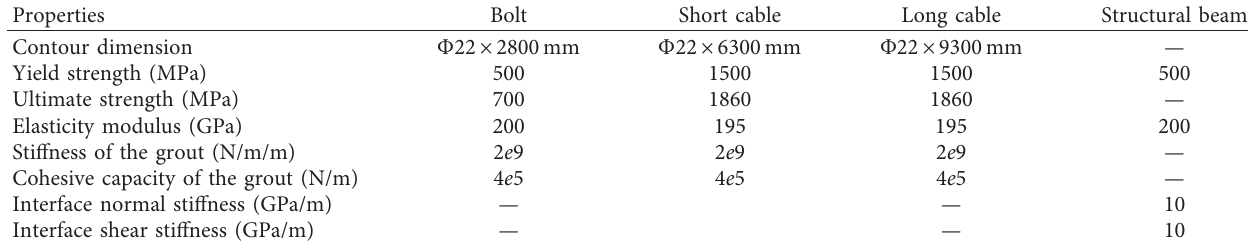
Table 2: Parameter table of support